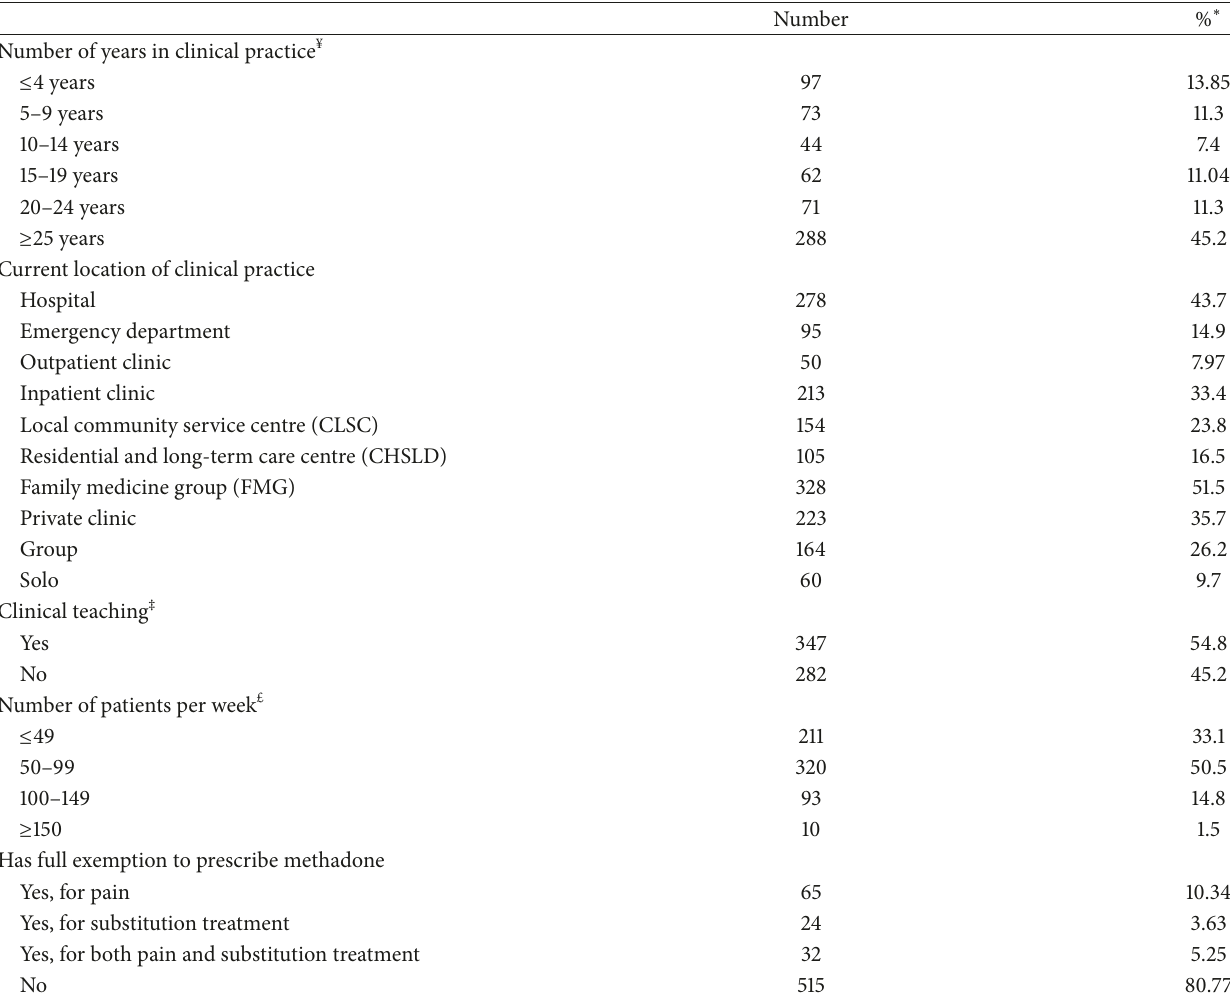
Table 2: Clinical practice profile of survey participants ( 𝑁 = 636